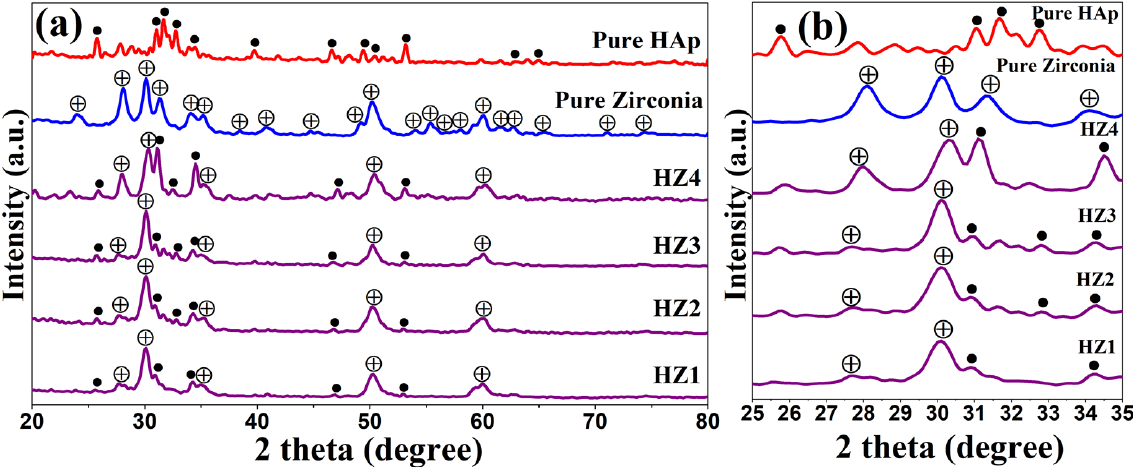
Figure 1. ( a ) XRD patterns of HAp, zirconia, and the HAp-Zirconia (HZ1–HZ4) composites ( b ) XRD patterns in the region of the major intensity peaks.